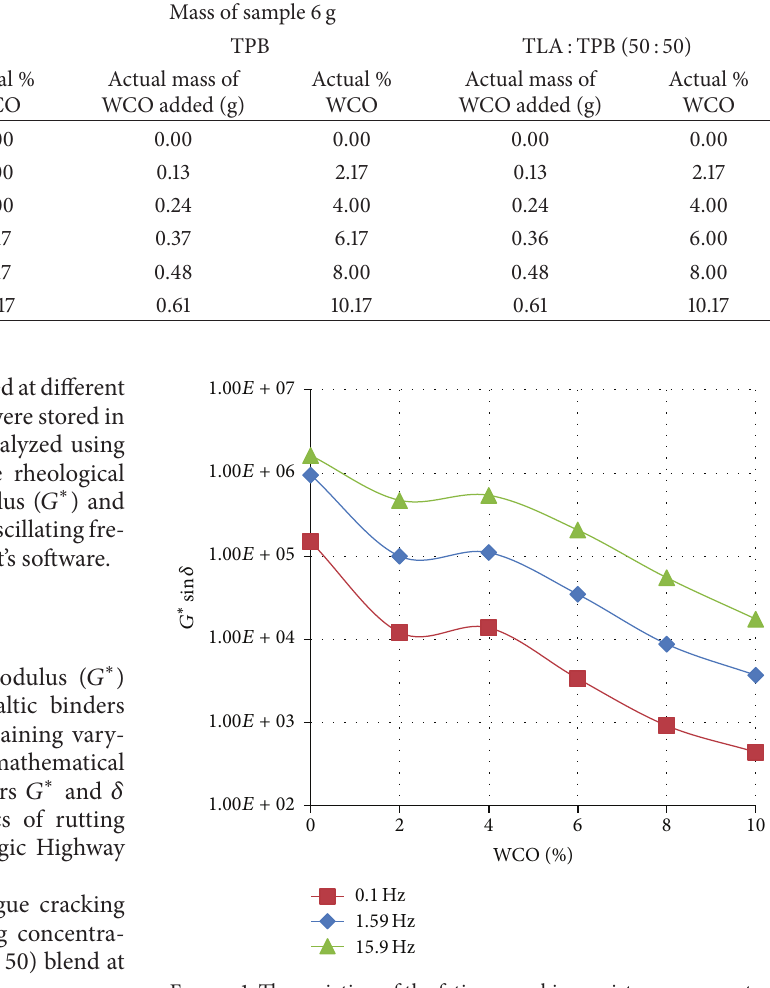
Figure 1: The variation of the fatigue cracking resistance parameter ( 𝐺 ∗ sin 𝛿 ) with increasing concentration of WCO in TLA at various oscillating frequencies at 60 ∘